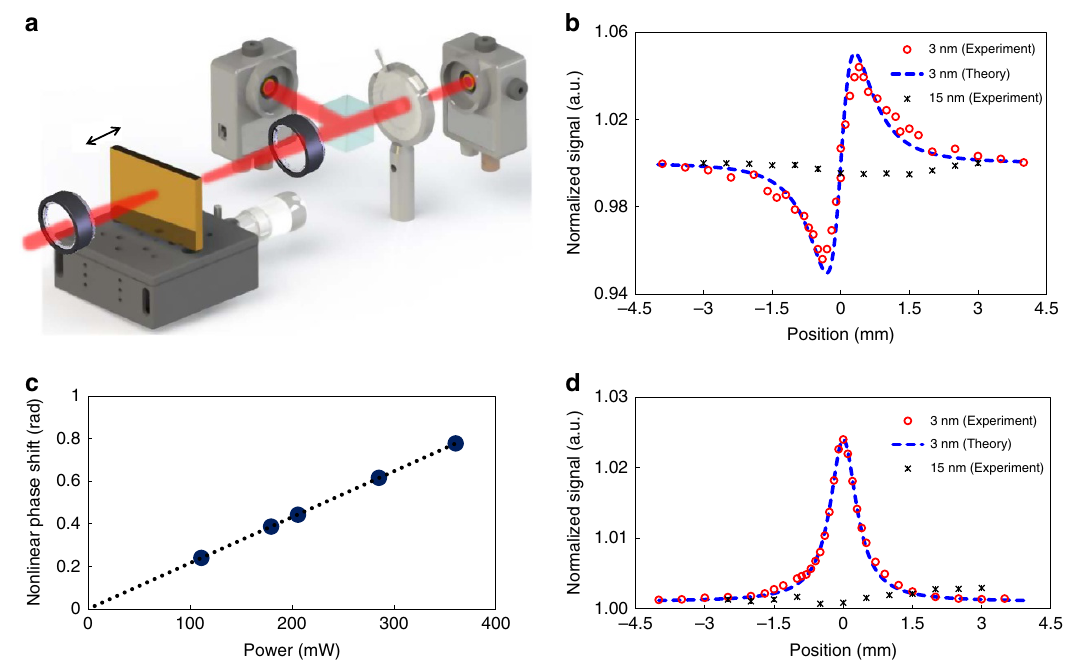
Figure 2 | Z -scan nonlinear measurement. ( a ) Schematic z -scan setup for third-order nonlinearity characterization. A femtosecond laser beam (Ti- sapphire laser, Mai Tai HP from Spectra-Physics, linearly polarized, 80fs width and 80MHz repetition rate) is focused onto the MQW sample through a lens ( f ¼ 3cm). The raw laser beam diameter is about 3.5mm, resulting in a Gaussian beam waist about 9 m m at the focus. The MQW is moved along the optical axis near the focus, two power metres are used to record the open and closed aperture z -scan signal through one collimation lens and a beam splitter. The closed aperture ( b ) and open aperture ( d ) z -scan curves for the 3nm (red-circle) and 15nm (black-cross) Au films using 900nm incident wavelength with power of 111 and 690mW. The closed aperture data are normalized to that of the open aperture. Z -scan signal of 3nm sample is fitted by the standard z -scan theory (blue-dashed), from which the Kerr coefficient is extracted. ( c ) The measured nonlinear phase shift for different incident power. The dashed line is the mathematically linear fitting for the measurement data and nonlinear phase change is zero at zero